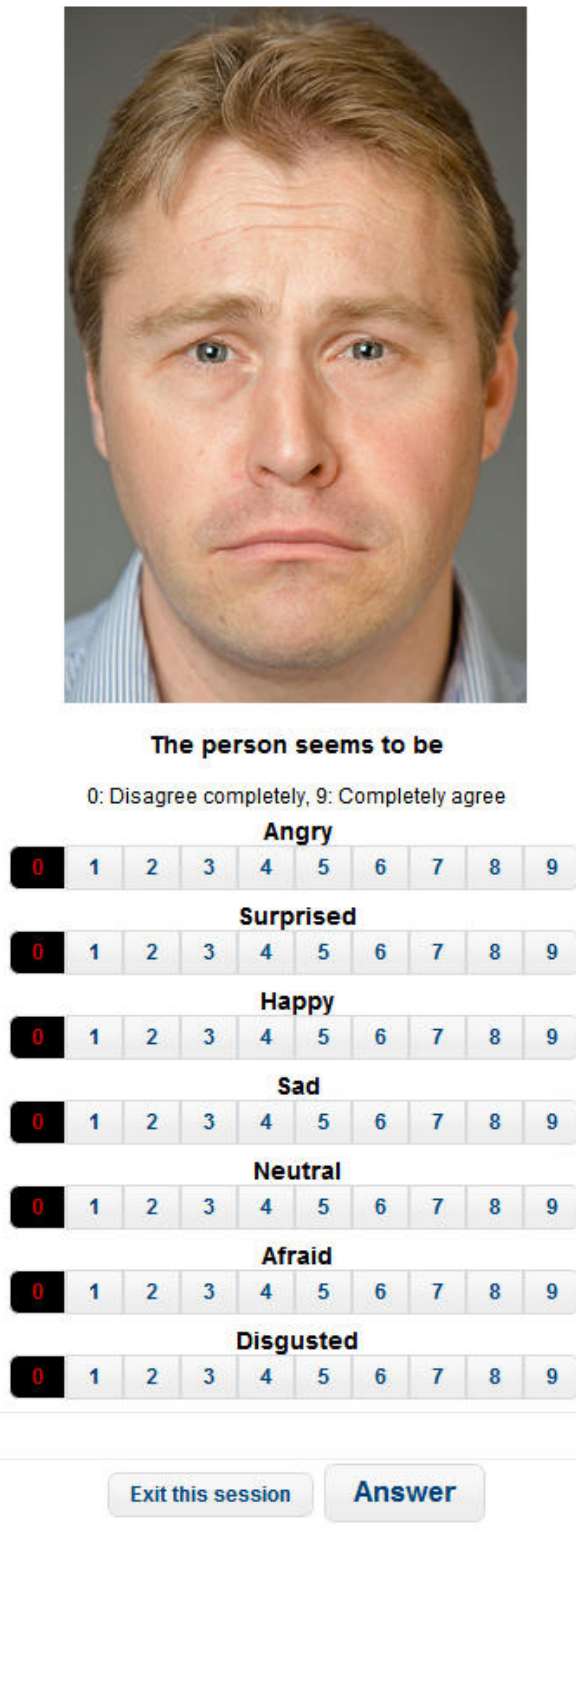
Figure 1. A screen shot of the web-based